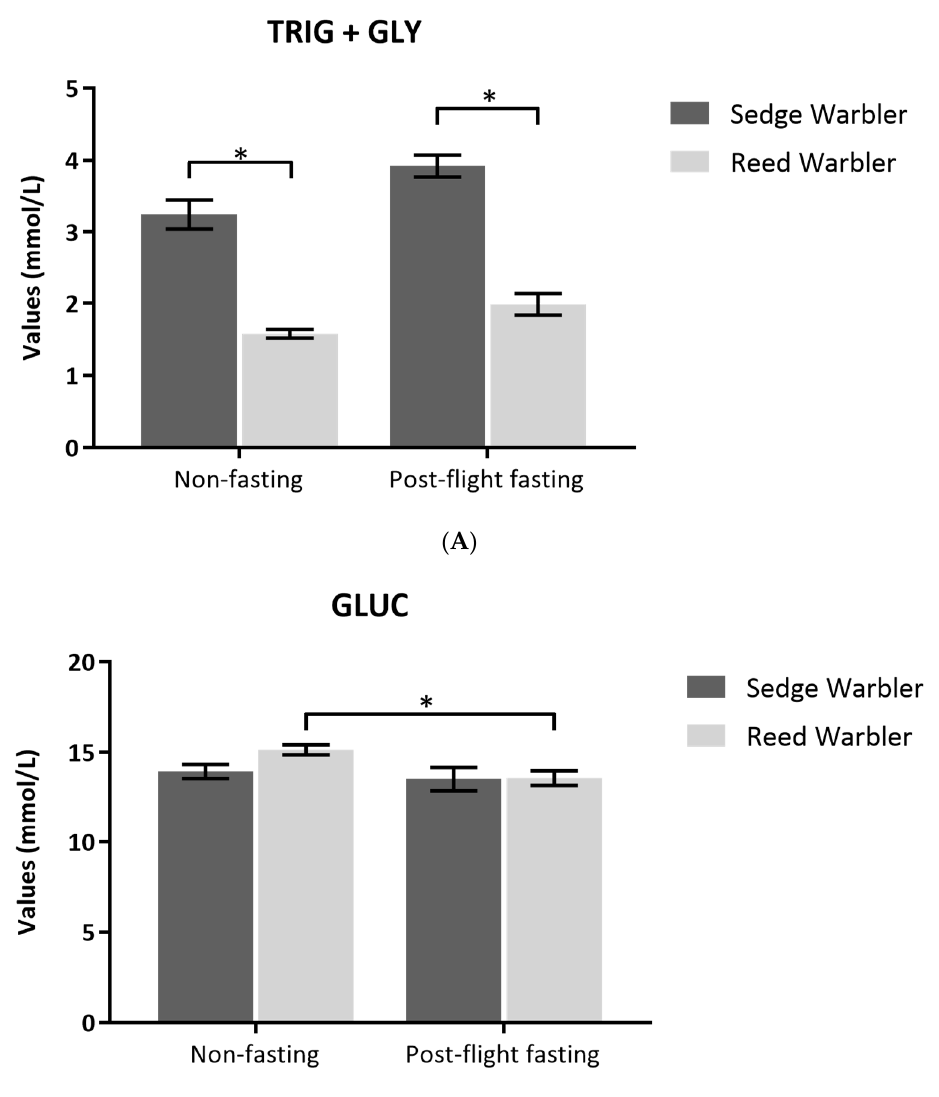
Figure 4. ( A ) Comparison of Triglycerides (TRIG) + Glycerol (GLY) (mmol/L) and ( B ) Glucose (GLUC) (mmol/L) values (mean ± SE) measure at field between non-fasting (stopped naturally) and post-flight fasting birds (tape lured) of Sedge and Eurasian Reed Warblers (Reed Warbler). Significance codes: *** = P < 0.001; ** P < 0.01; * P < 0.05.